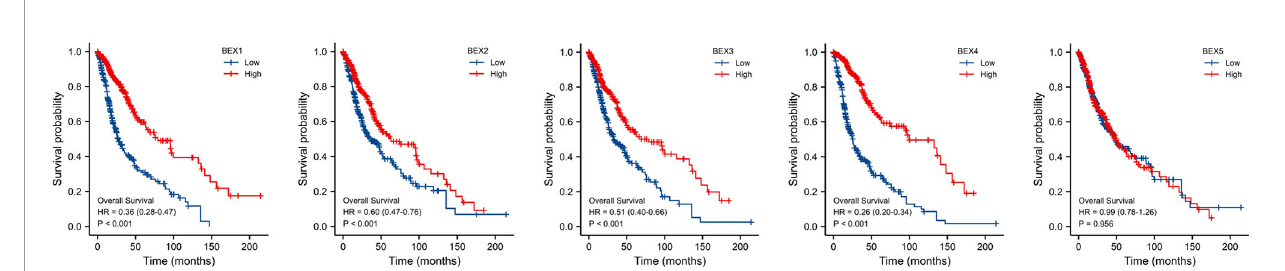
FIGURE 2 | The OS of BEX family for GBM patients. The prognostic value of BEX family mRNA expression for OS in GBM patients by Kaplan – Meier analysis. The Cox regression analysis was performed to evaluate survival differences with the best cutoff value. OS, overall survival; GBM,